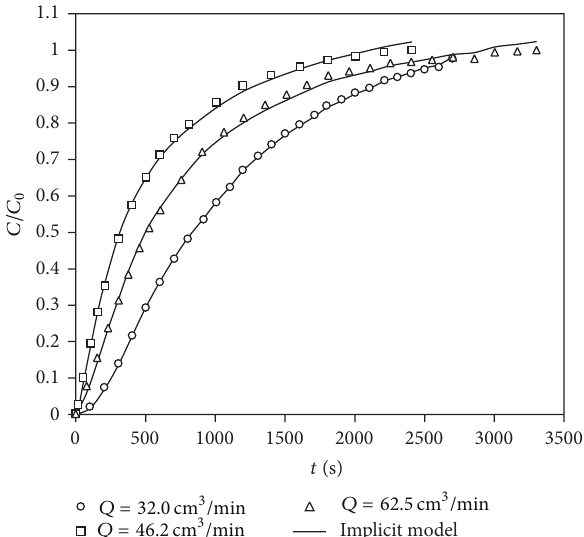
Figure 5: Breakthrough curves of propylene adsorption in zeolite 4A and different flow rate fitted with (2) [33].